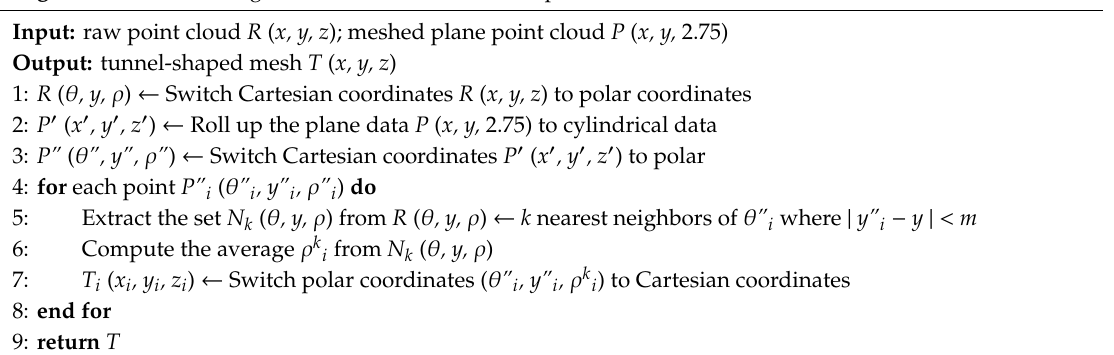
Algorithm 1. Converting the 2D mesh to a tunnel-shaped mesh